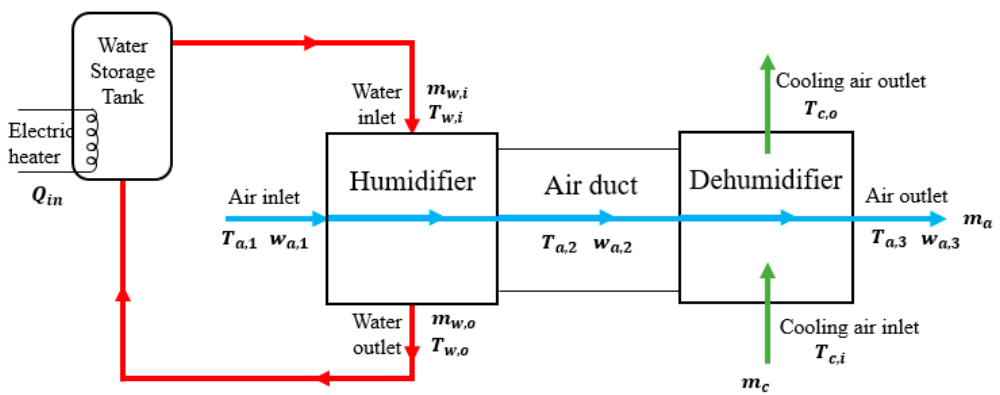
Figure 3. Photograph of the experiment setup.